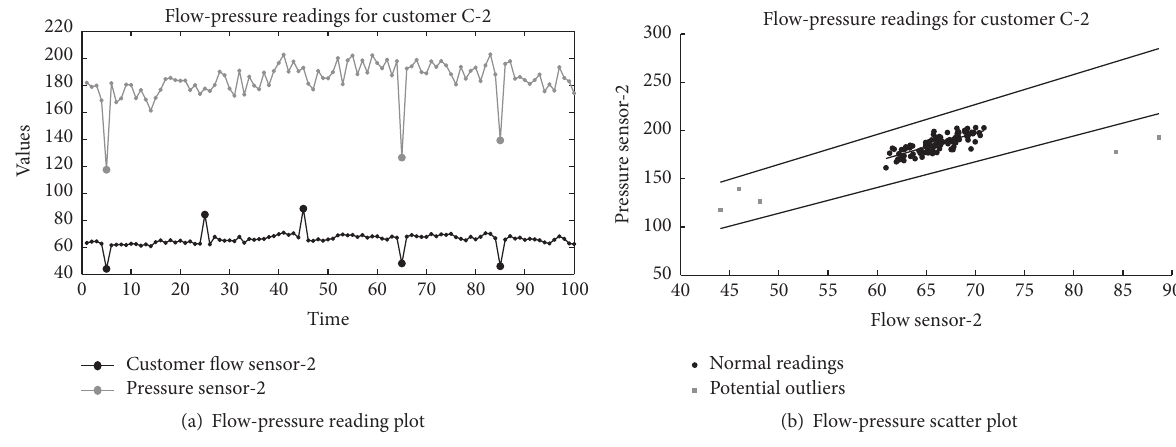
Figure 7: Simulated flow-pressure plots for customer